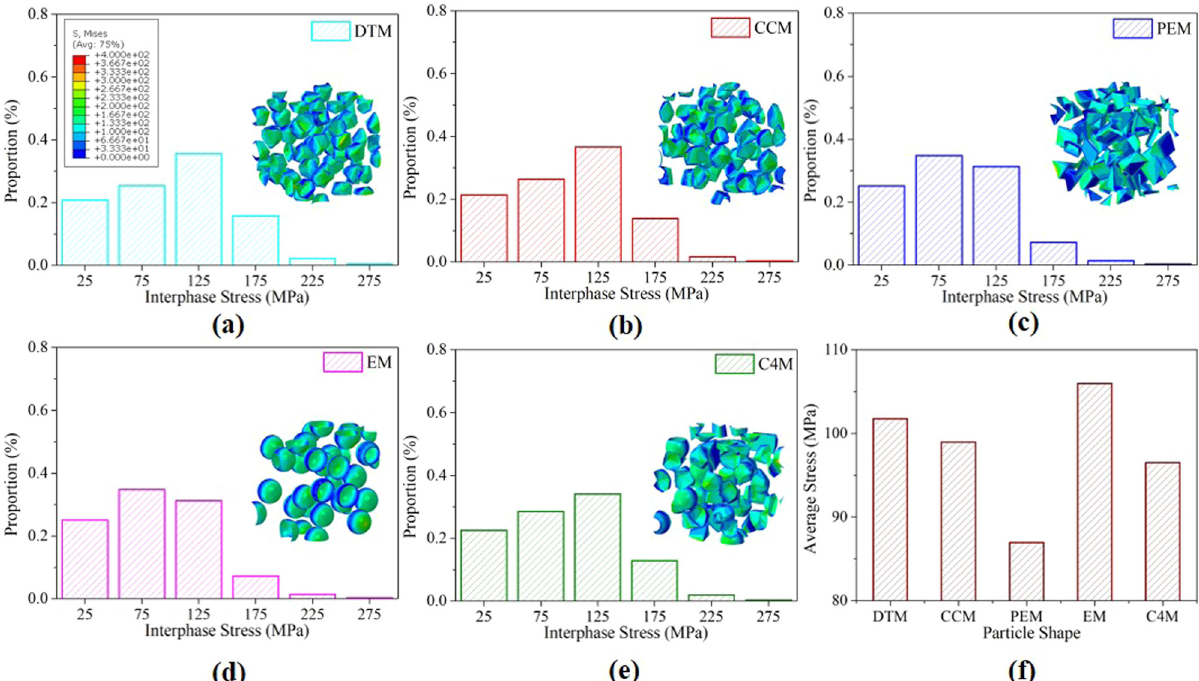
Figure 9: Interphase micro - stress distribution at a tensile strain of 0.1%: ( a ) DTM, ( b ) CCM, ( c ) PEM, ( d ) EM, ( e ) C4M, and ( f ) mean stress of